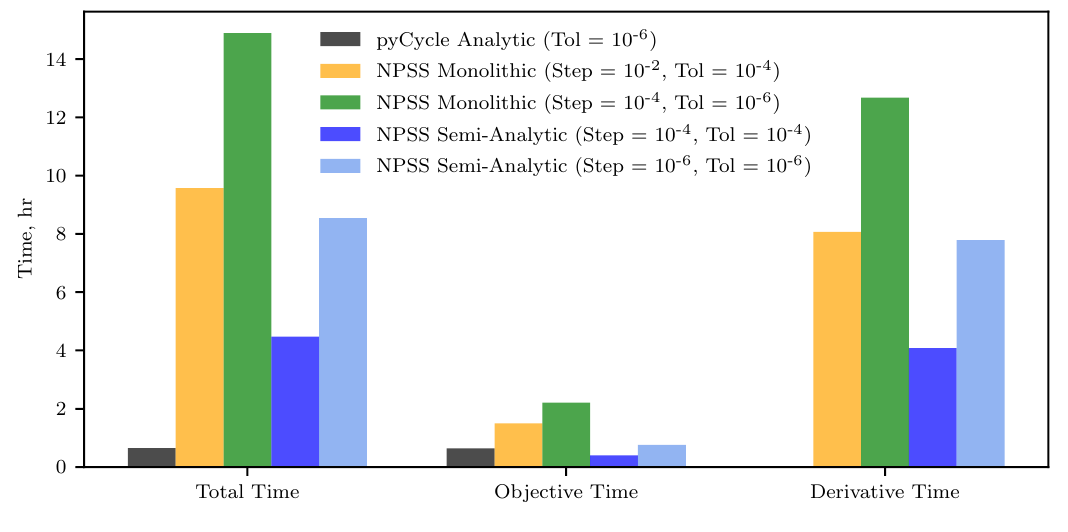
Figure 12. Optimization